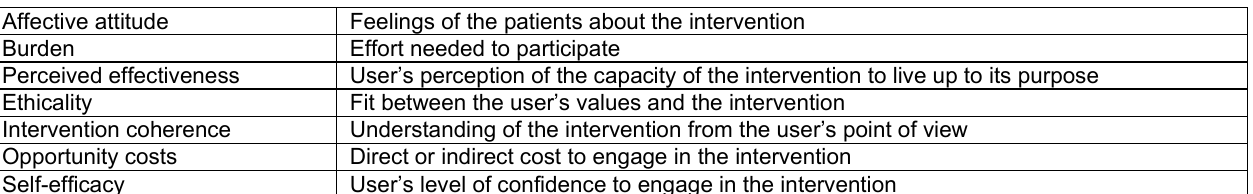
Seven Components of Acceptability According to Sekhon et al.,